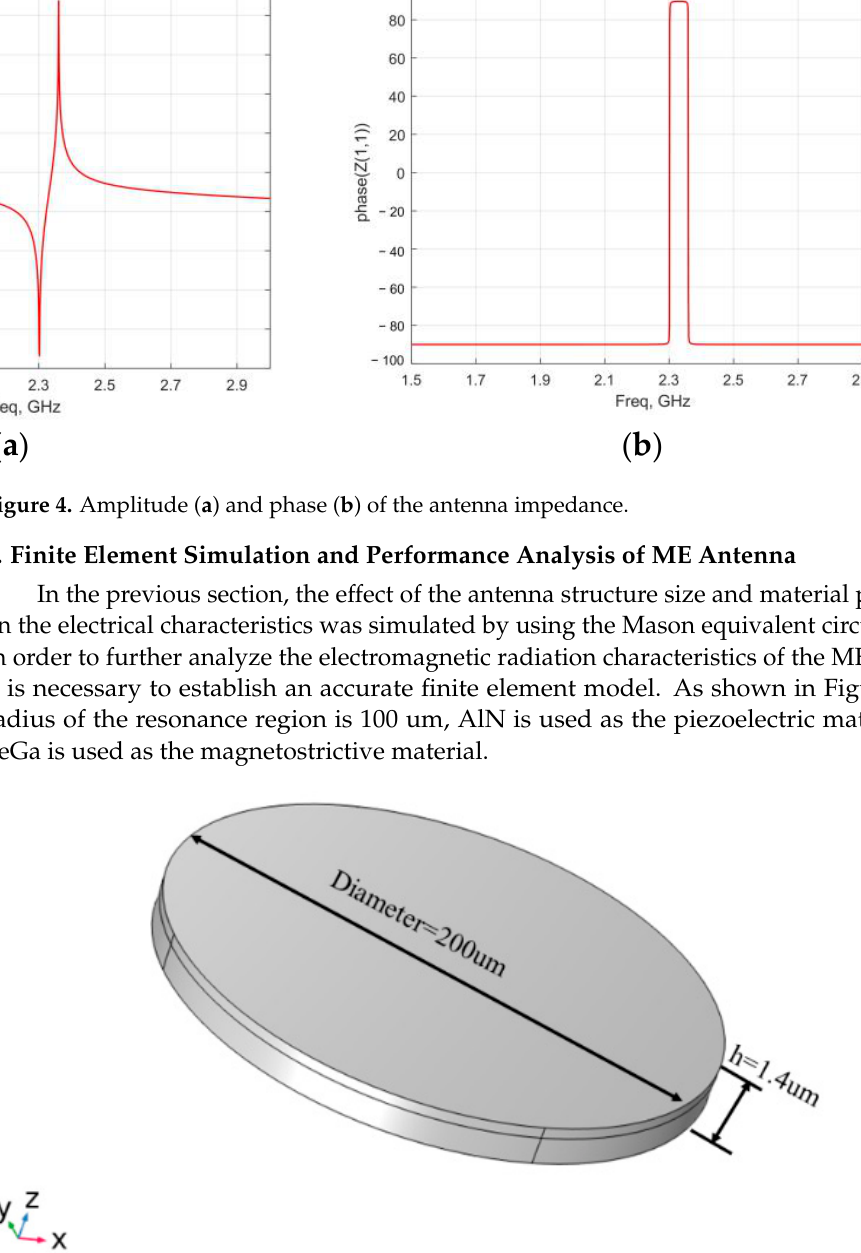
( d ) Figure 6. Distribution of the structure and electrical parameters of the ME antenna under a magnetic field. ( a ) Stress, ( b ) strain, ( c ) displacement and ( d ) electric potential. In order to determine the optimum structural parameters of the antenna, the influ- ence of the structural parameters on the resonant characteristics is analyzed [ Error! Ref- erence source not found. ]. 1. Influence of substrate